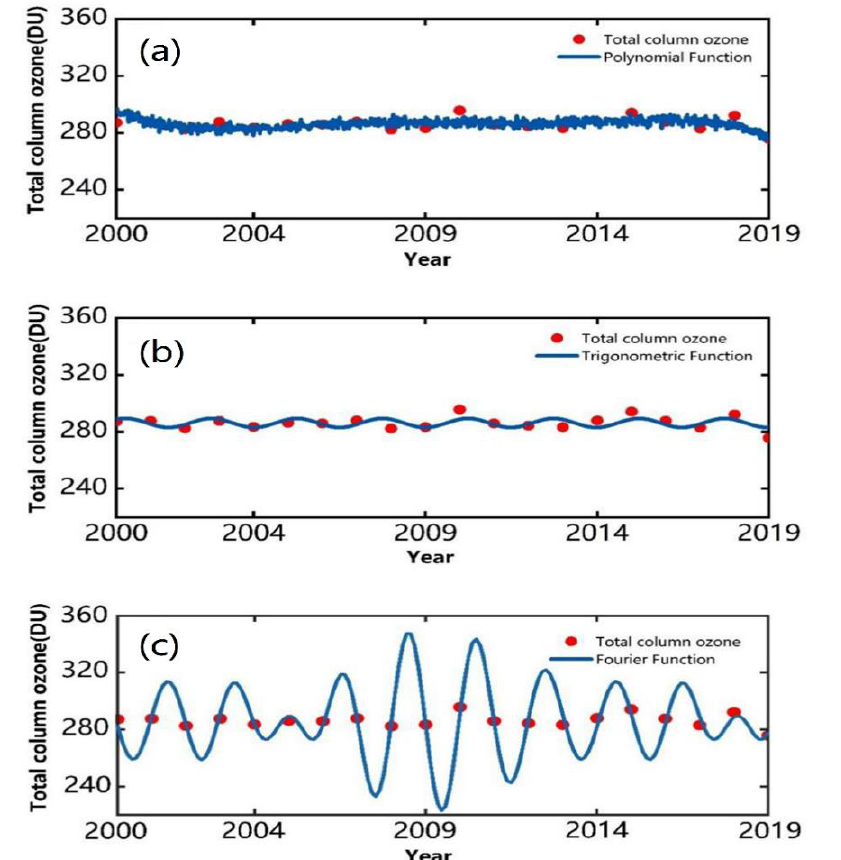
Figure 6. The fitting line charts of the TCO historical results during 2000 – 2019 over the Yangtze River Delta Urban Agglomerations by the polynomial function ( a ), the trigonometric function ( b ), and the Fourier function ( c ). Note: The fitted models were constructed based on the annual scale data, so the data corresponding to integer years (such as 2000, 2008, 2009, 2014, etc.) are meaningful and accurate data, and there is little reference in the other values and the fluctuance patterns of the fitting lines; for real interannual changes, please refer to Figure